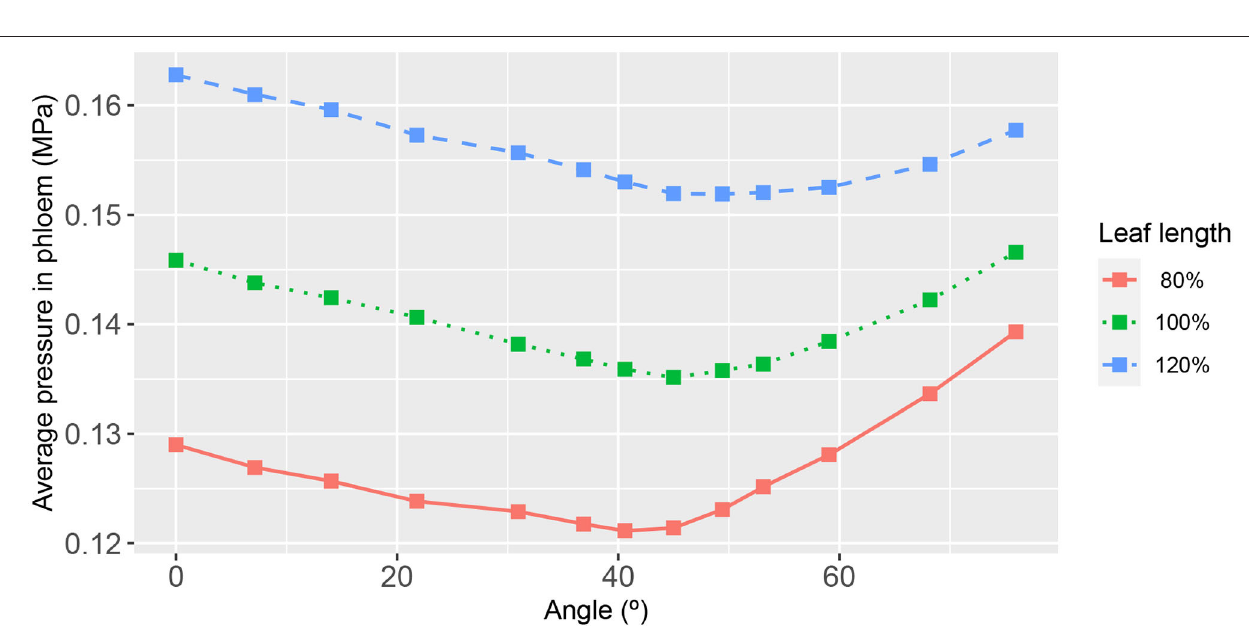
FIGURE 9 | The functional relationship between leaf area-average, hydraulic pressure in the phloem and second-order vein angle. Curve descriptions and simulation conditions are as in this figure except with a xylem/phloem conduit conductance of K ij − c = 5 × 10 − 4 mmol s − 1 m − 2 (i.e., reduced by a factor of 10 3 ).